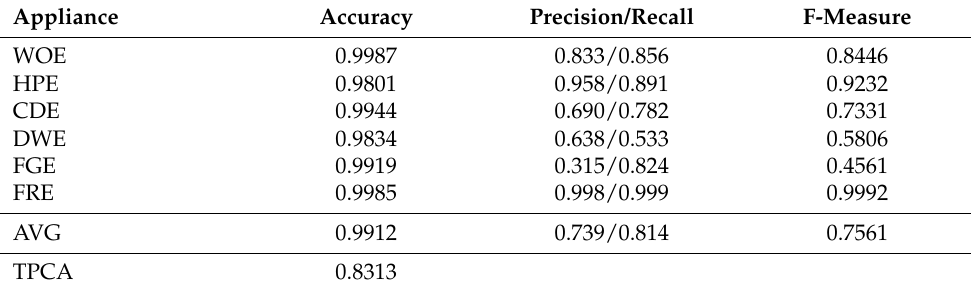
Table 5. Simulation Results Summary.